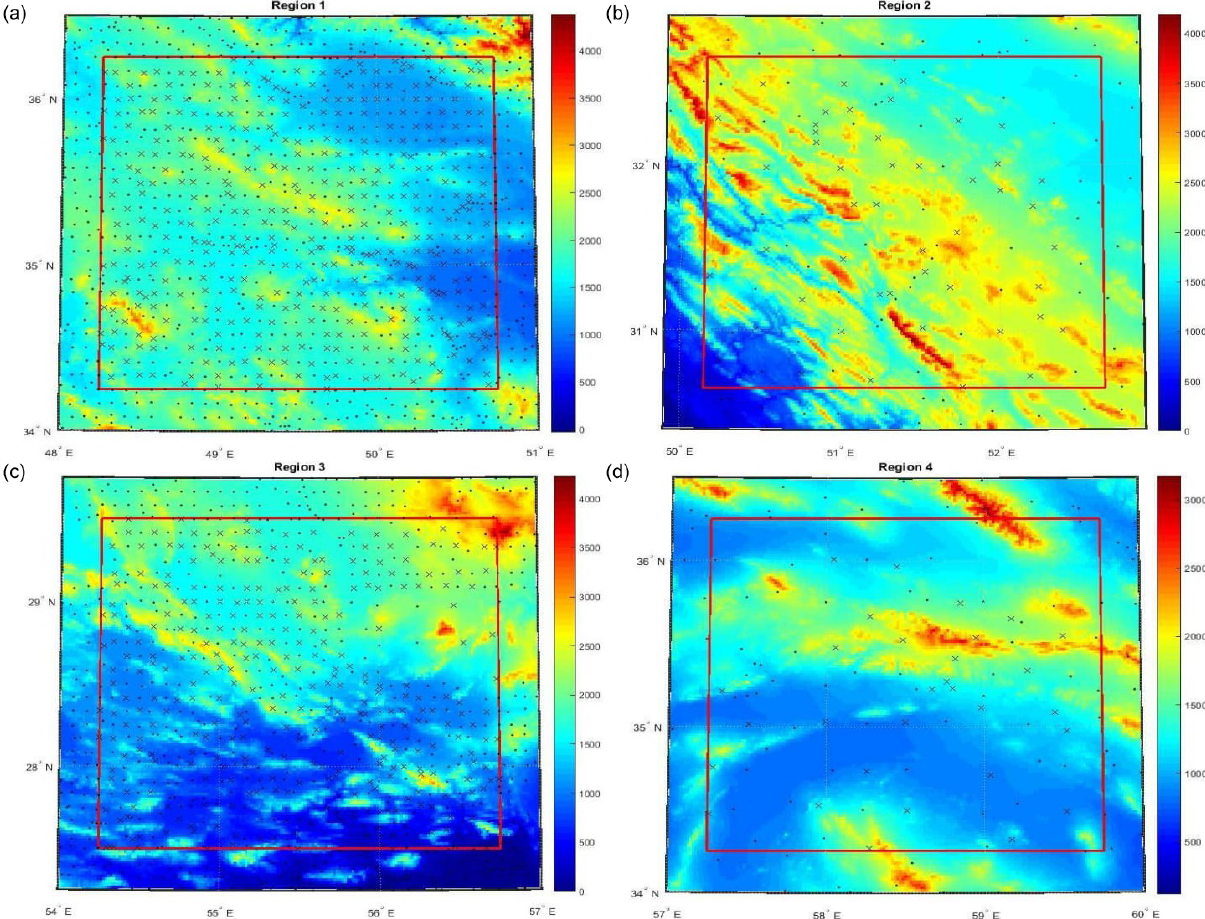
Figure 4. Observations (dots) and control points (crosses) in the regions (a) R1, (b) R2, (c) R3 and (d) R4 after refining the data distribution. Topography as background